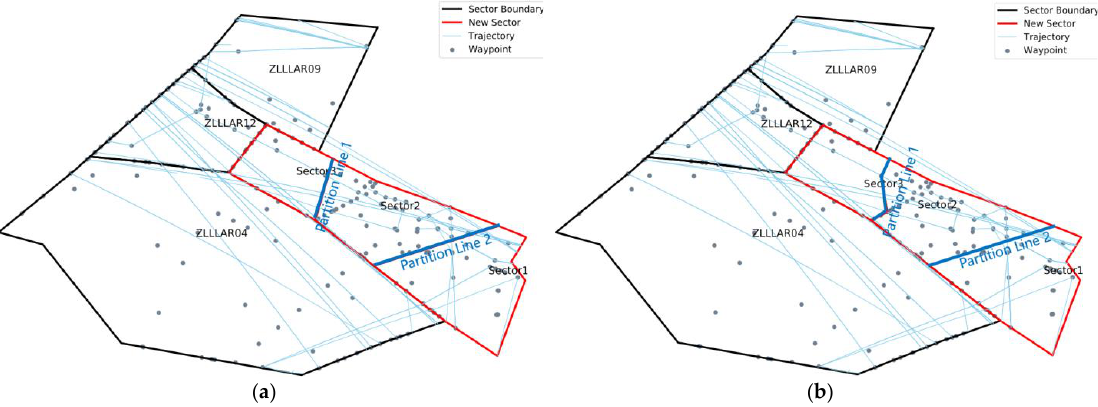
Figure 11. ( a ) 10:00 – 11:59 After one-stage; ( b ) 10:00 – 11:59 After two-stage. Table 7. 10:00 – 11:59 Workload values for each sector before and after optimization. Before